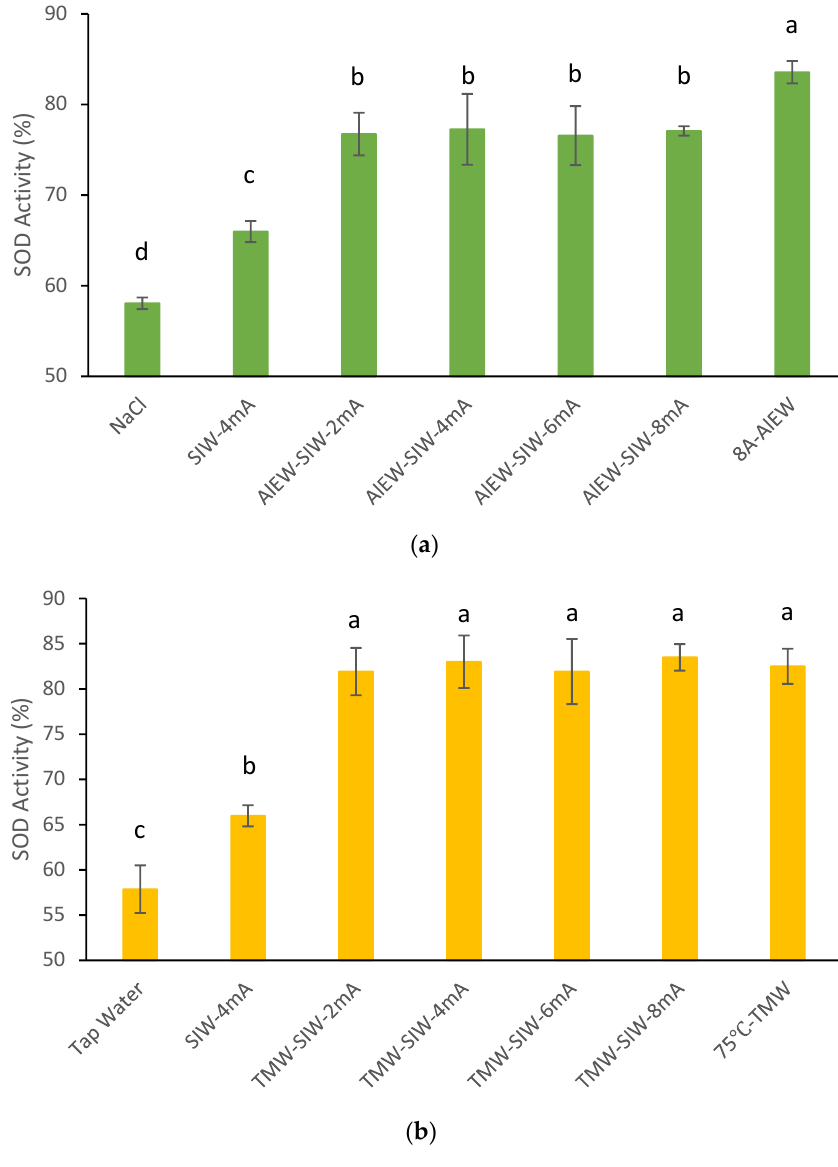
Figure 3. SOD activity of AlEW-SIW ( a ) and TMW-SIW ( b ) solutions. AlEW-SIW and TMW-SIW represent the silver-ionized water produced by using AlEW generated at an electrolytic current of 8 A or TMW generated at a tourmaline stone treatment temperature of 75 ◦ C as the electrolyte, respectively. AlEW/TMW-SIW-x mA means the electrolytic current of x mA for silver-ionized water (x = 2, 4, 6, 8). NaCl solution and tap water were used as controls. Different letters indicate a significant difference ( p < 0.05). Each value is expressed as the mean value ± standard deviation of three replicates. All sample solutions in this study contained 2 mmol/L AsA.